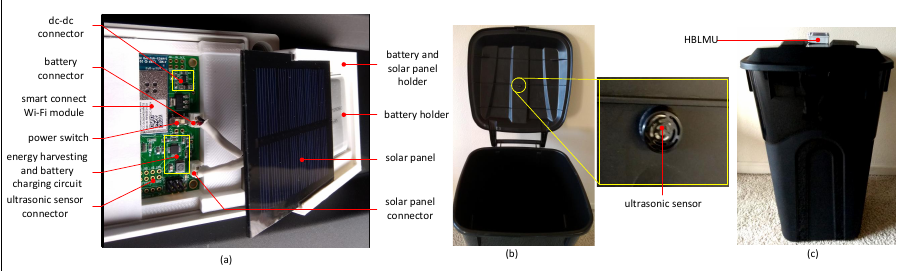
Figure 4. ( a ) Various components of the fabricated HBLMU. ( b ) Installation of HBLMU on a trash bin. ( c ) Front view of the HBLMU equipped trash